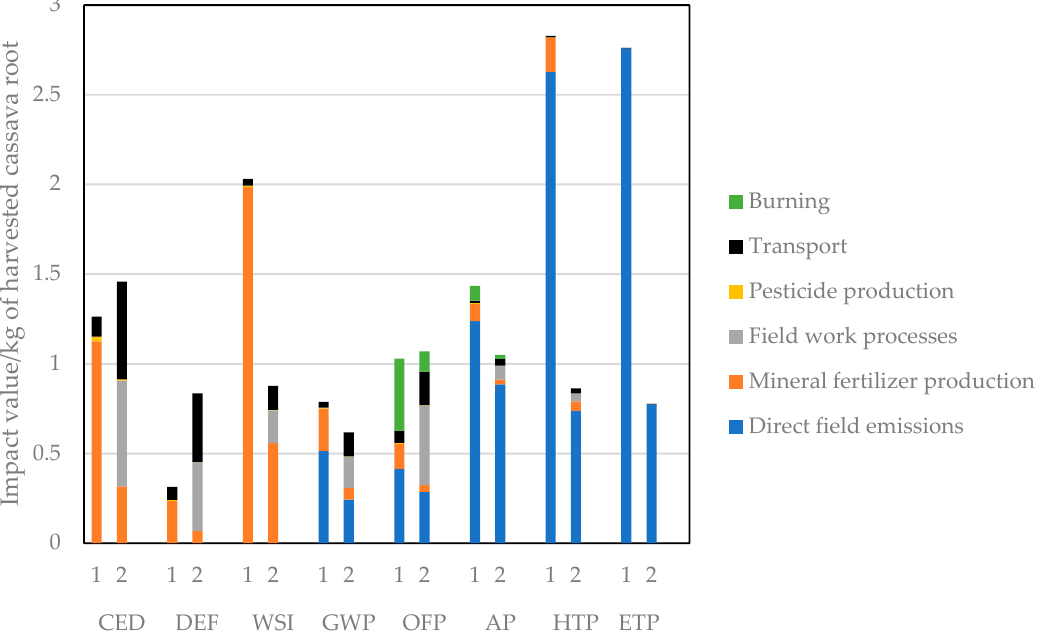
Figure 2. Environmental impacts of traditional (1) and modern (2) cassava cultivation per kg of harvested cassava root; cumulated energy demand (CED) in MJ, deforestation (DEF) in 4 × 10 − 3 m 2 , water stress index (WSI) in 4 × 10 − 2 m 3 , global warming potential (GWP) in 4 × 10 0 kg CO 2 -eq, ozone formation potential (OFP) in 10 − 2 kg NMVOC-eq, acidification potential (AP) in 2 × 10 − 1 mol H + , human toxicity potential (HTP) in 10 − 4 kg 1,4-DB-eq and ecotoxicity potential (ETP) in 10 − 2 kg 1,4-DB-eq.